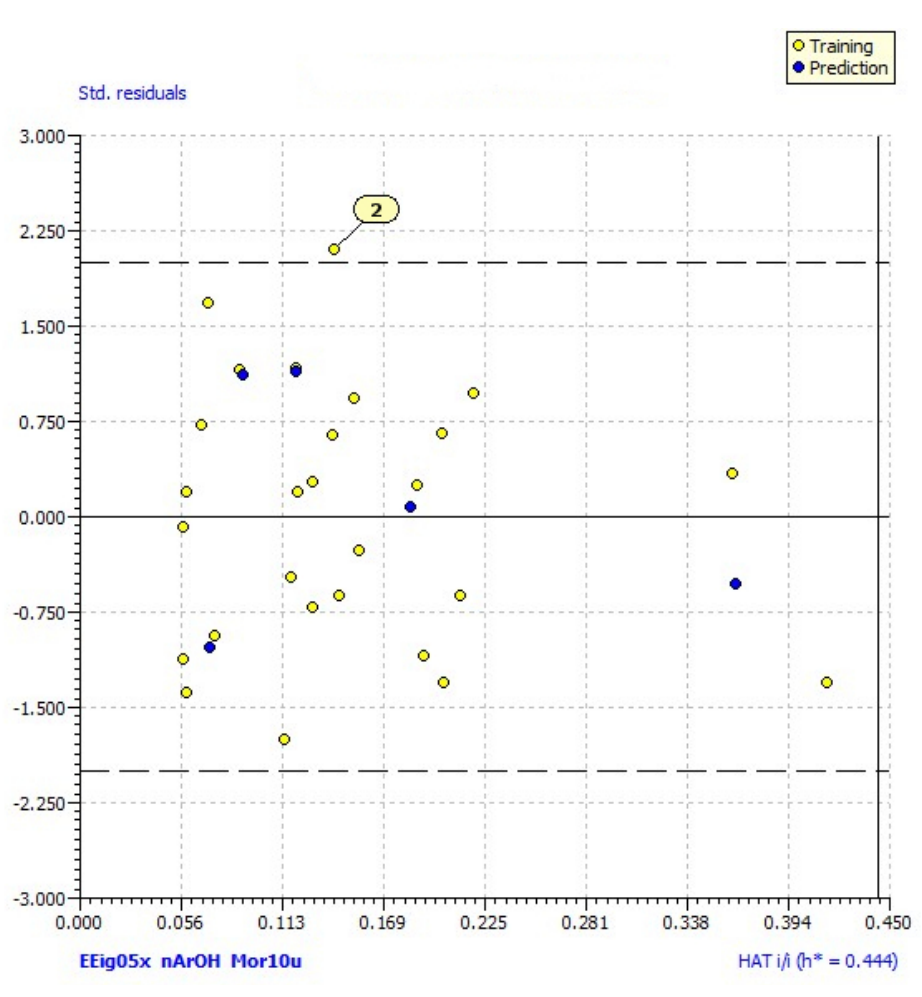
Table 3. Correlation matrix (with correlation coefficient values R ) for descriptors used in Equation (2).